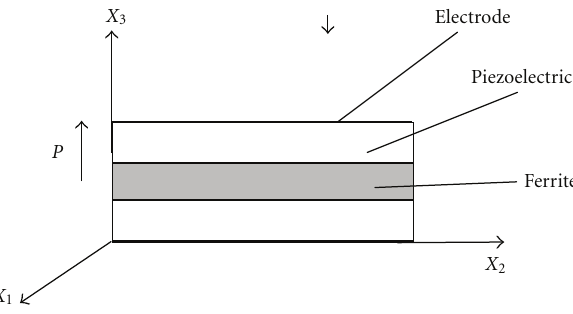
Figure 1: Schematic of the layered composite